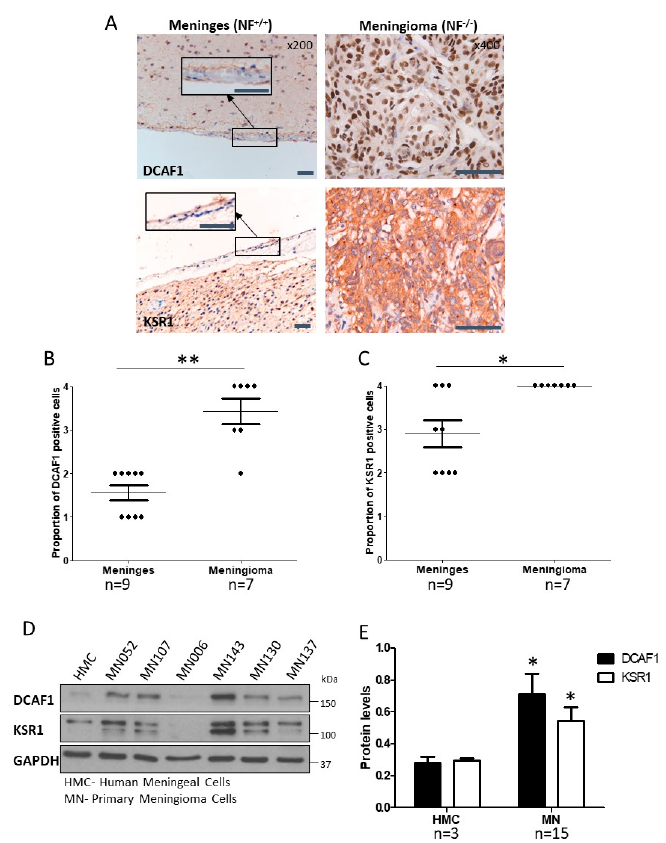
Figure 1. DDB1 and Cullin 4-associated factor 1 (DCAF1) and Kinase suppressor of Ras 1 (KSR1) are overexpressed in Merlin-deficient grade I meningioma, compared to normal cells. ( A ) Representative immunohistochemical images of normal meninges (200 × with 400 × insert) ( n = 9) and meningioma (400 × ) ( n = 7) tissue, stained with DCAF1 and KSR1 antibodies and counterstained with haematoxylin. In meningioma, DCAF1 expression was mostly nuclear with some diffuse cytoplasmic expression, whilst KSR1 expression was diffuse and granular in the cytoplasm, with some strong paranuclear expression. Scale bar—50 µM; ( B ) and ( C ) Proportions of DCAF1 and KSR1 positive cells in nine normal meninges and seven meningioma tissues are plotted, where a score of 1 was less than 25% of cells expressing the protein, a score of 2 was between 25% and 50%, a score of 3 was between 51% and 75% and a score of 4 was more than 75%. ** p < 0.01, * p < 0.05; ( D ) Representative Western blot showing DCAF1 and KSR1 expression in human meningeal cells (HMC; n = 3) and meningioma cells (MN; n = 14); ( E ) Mean DCAF1 and KSR1 expression and standard error of the mean (SEM) in HMC and MN normalised to the loading control, GAPDH. * p < 0.05, ** p < 0.01. The whole western blot image please find in Figure S8.